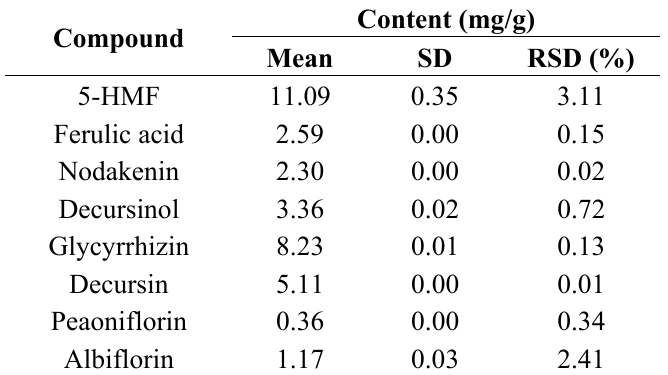
Table 2. Content of the eight marker compounds of Palmultang ( n =